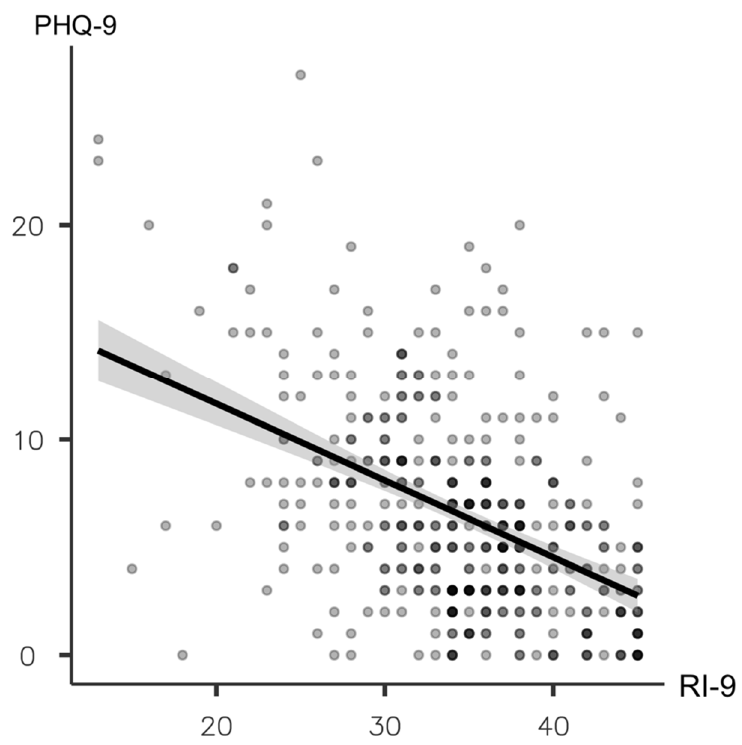
Figure 1. Pearson’s correlation test between Resilience Index (RI-9) and depressive symptoms (PHQ-9).